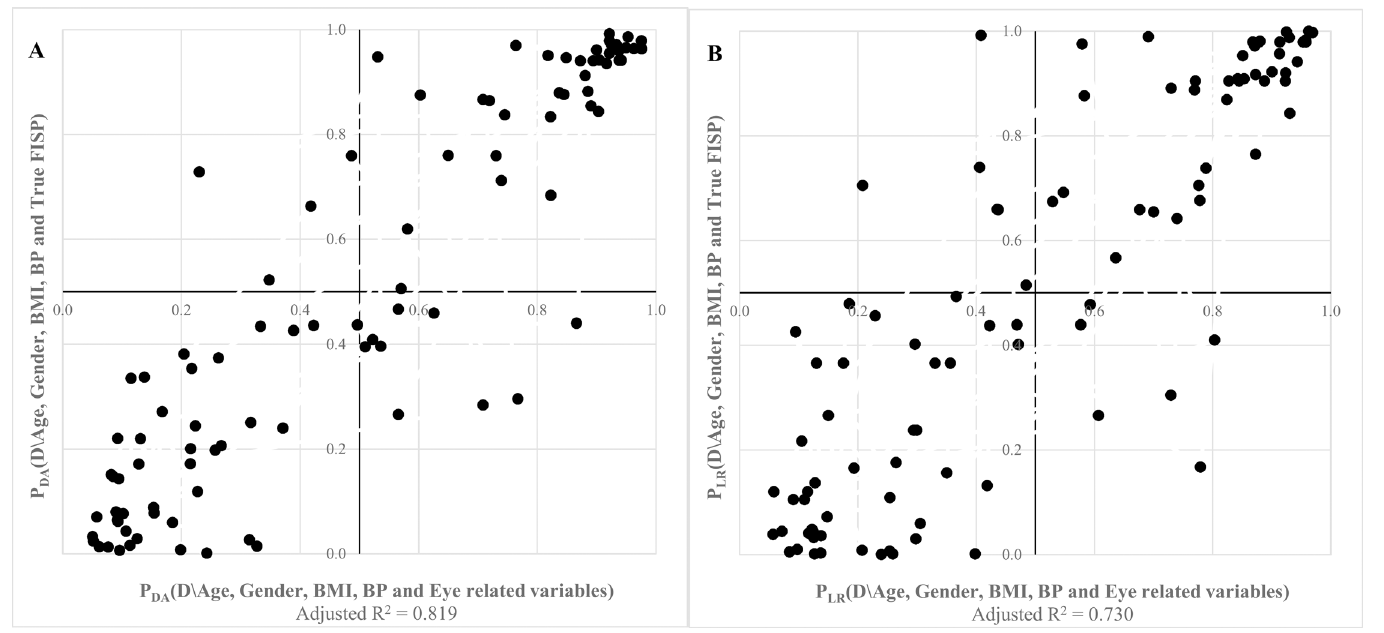
Fig 2. Correlation between eye and left ventricle function using discriminant analysis models (A) or logistic regression models (B).